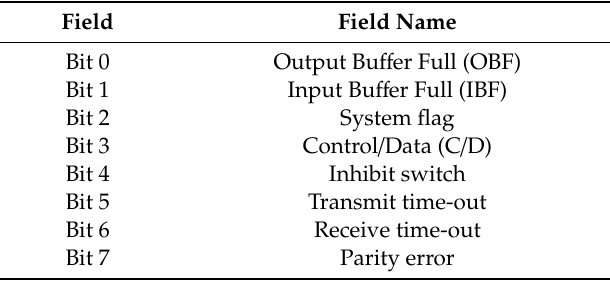
Table 1. Configuration of the keyboard controller status